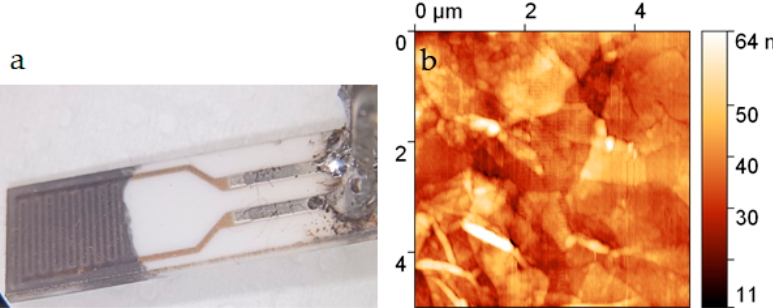
Figure 2. Sample characterization: ( a ) optical photograph of the graphene sensor; ( b ) atomic force micrograph of the sensor surface.